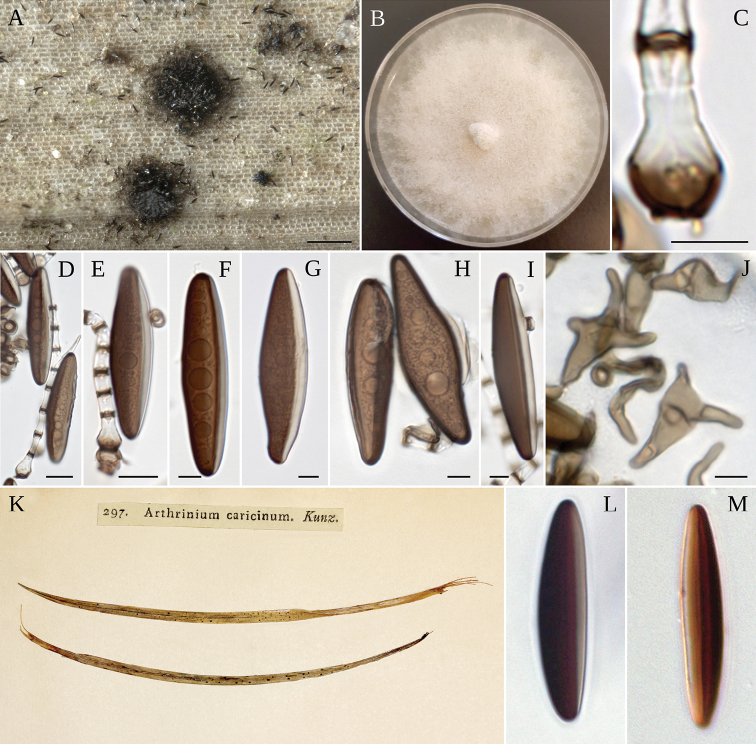
A.caricicolaA colony on host B colony on MEAC conidiophore mother cell D, E conidiophore mother cell, conidiophore bearing conidia, conidia F–H conidia I conidia with scar J lobate sterile cells. Scale bars: 200 µm (A); 5 µm (C–I); 10 µm (J). KA.caricicola syntype, colonies on host; L, M conidia.